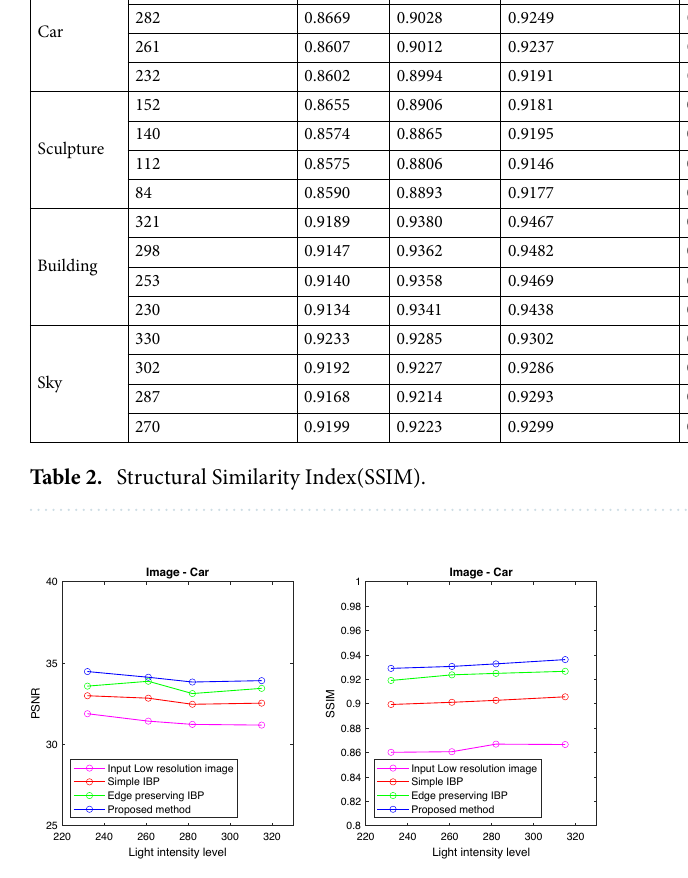
Figure 6. PSNR and SSIM plotted against light intensities—Car image.